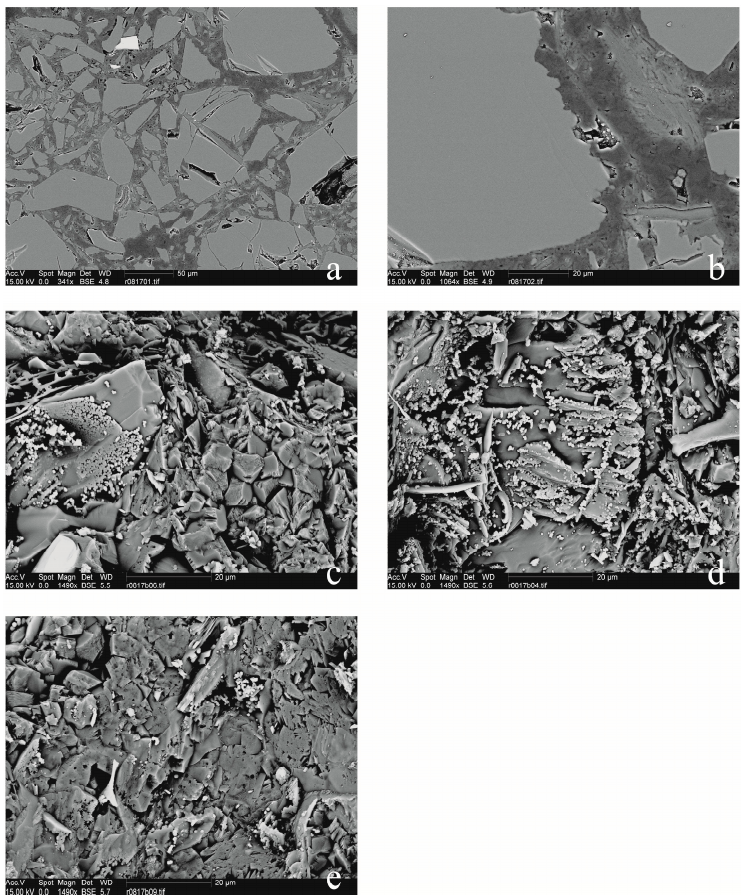
Figure 7. Polished section SEM micrograph showing a typical microstructure for reacted powder sample R0813. Note again the very low sample porosity with a cement phase closely surrounding the olivine grains. Due to sample preparation, R0813 contained some pre-existing cracks which during the experiment were filled with magnesite (dark gray). Open cracks in the sample were caused by removing the sample from the titanium vessel. The larger gray areas in the sample are grains of (hydro-)magnesite that were added to the starting material.